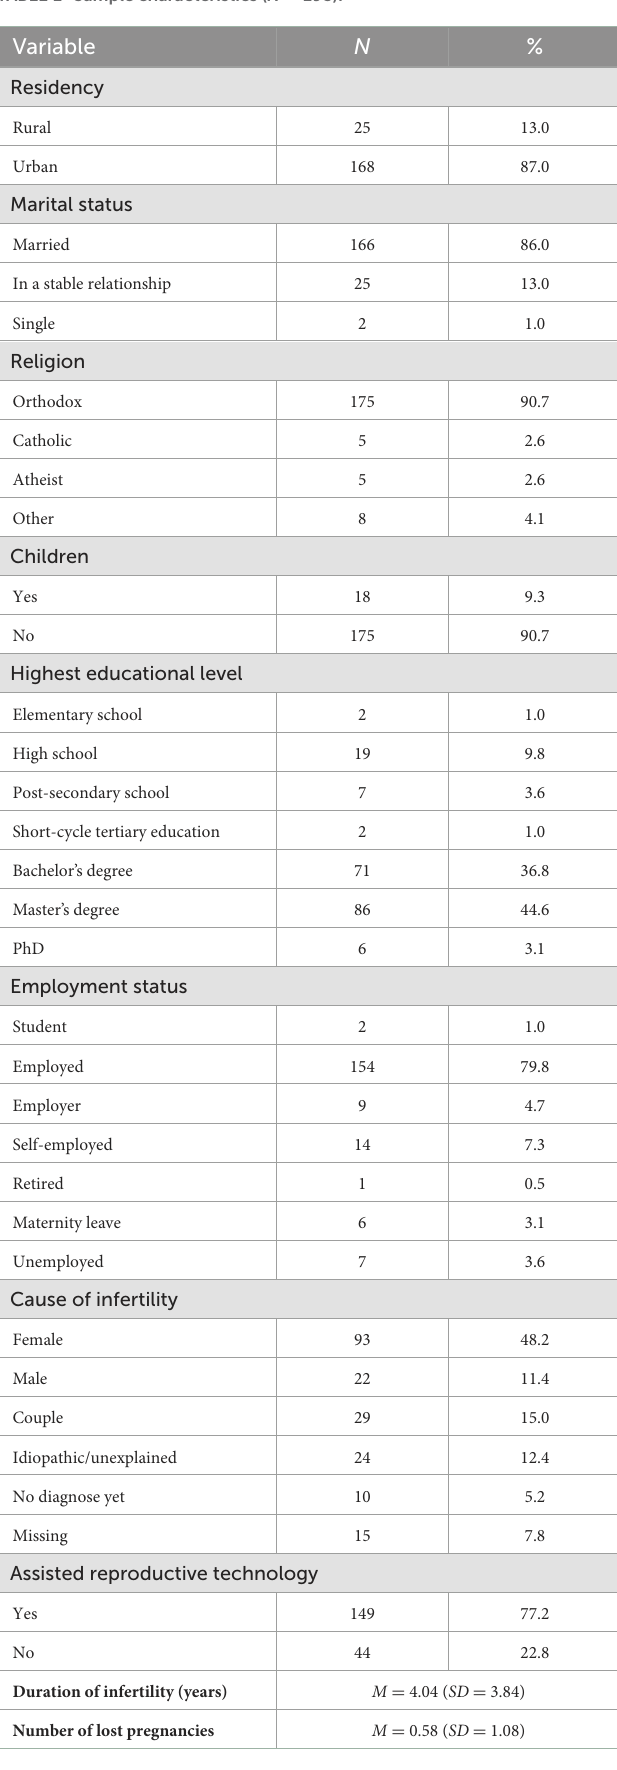
TABLE 1 Sample characteristics ( N =